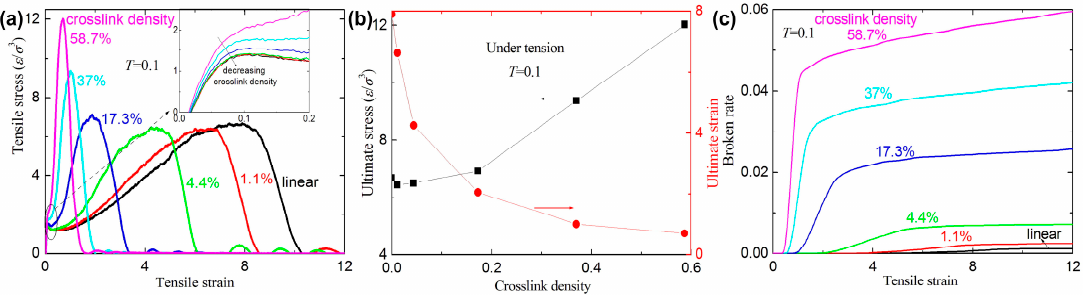
Figure 3. ( a ) The tensile stress-strain curves with different crosslink density at temperature T = 0.1; ( b ) the ultimate stress and the ultimate strain versus crosslink density; and ( c ) the broken ratio versus crosslink density at temperature T = 0.1.